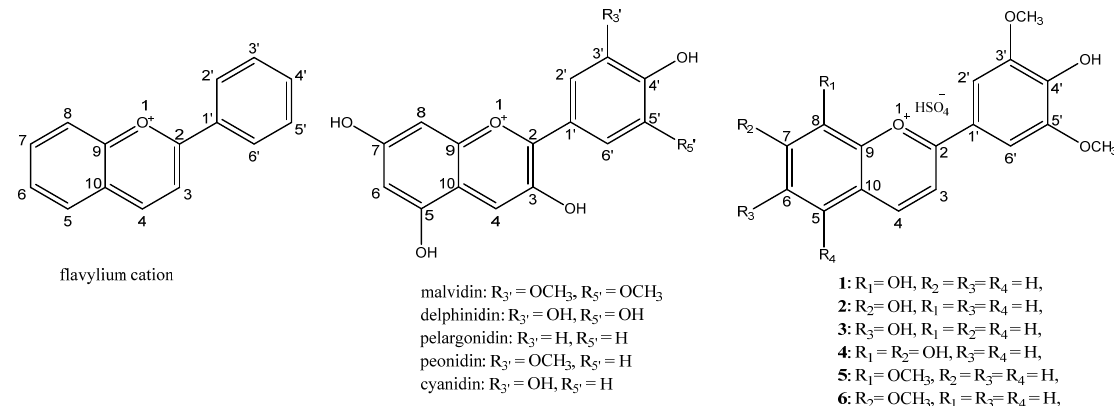
Figure 2. Structure of the flavylium cation, five natural and six (1–6) synthetic anthocyanidins.